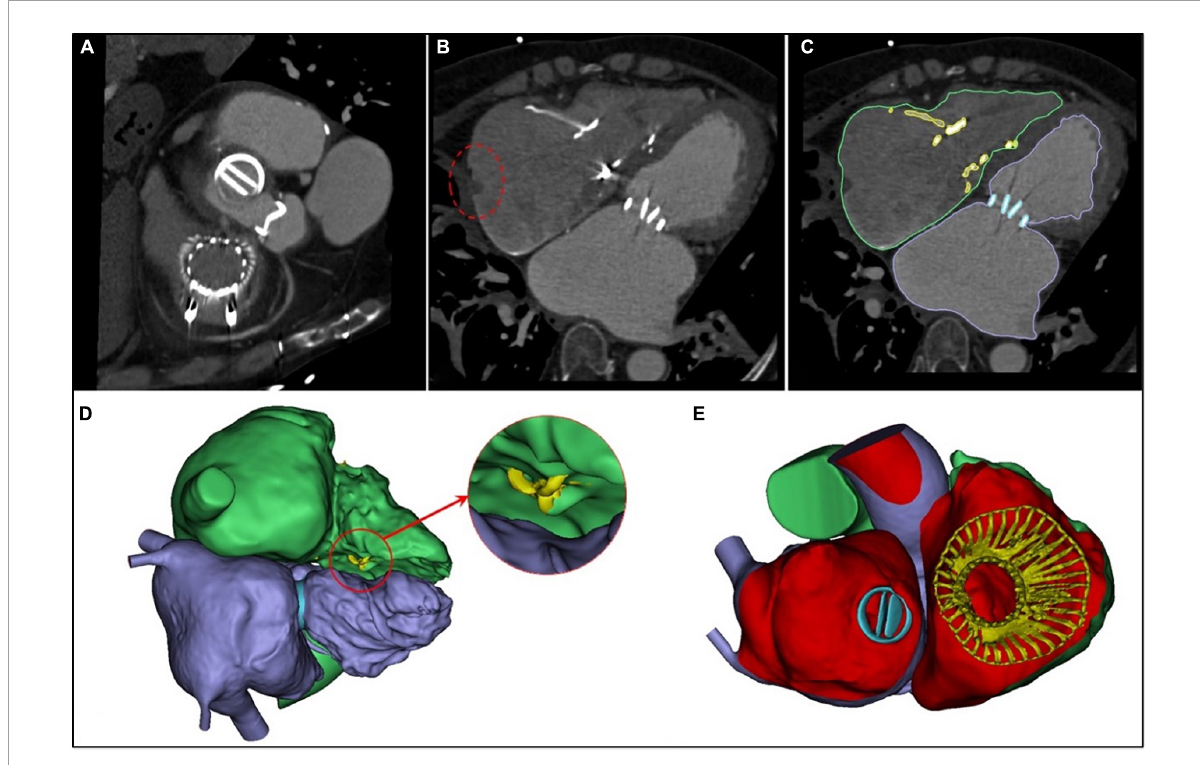
FIGURE4 Postprocedural evaluation of the interventricular anchor. (A) A multislice computed tomography scan showed the precise positions of the two graspers. (B) The incision of the right atrium (the red circle) corresponds with Figure 1F . (C) The right heart is outlined in green; the left heart, in purple; the mechanical valve, in blue, and the LuX-Valve is yellow. (D) The yellow area in the red circle is the interventricular anchor. (E) The 3-dimensional reconstructed image from the right atrial plane demonstrates that the LuX-Valve is located in the normal position.